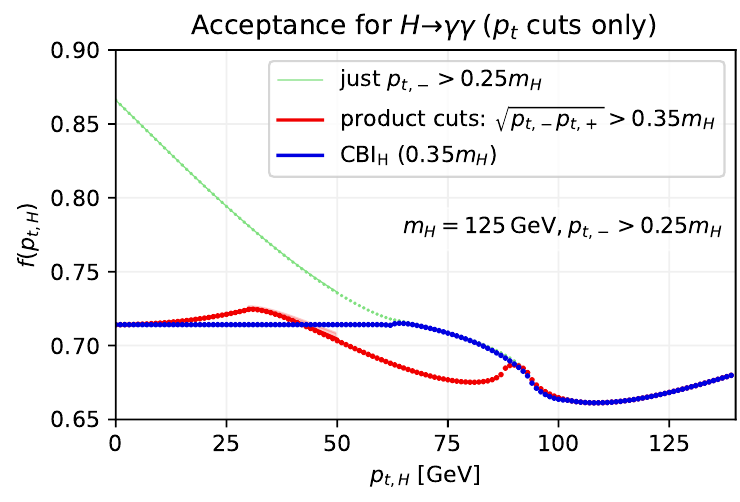
Figure 12 . Acceptance of the hardness compensating boost-invariant (CBI H ) cut, as a function of p t, h , compared to the product cuts of section 3.2 and the maximum possible acceptance that can be achieved with the underlying p t, − > 0 . 25 m h